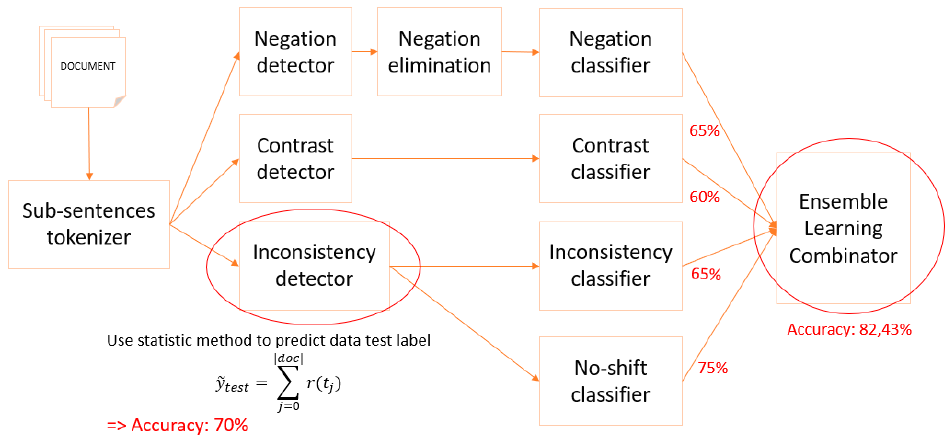
Appl. Sci. 2019 , 9 , x FOR PEER REVIEW Figure 11. Average accuracy of the Xia et al. approach. Figure 11. Average accuracy of the Xia et al. approach [5].